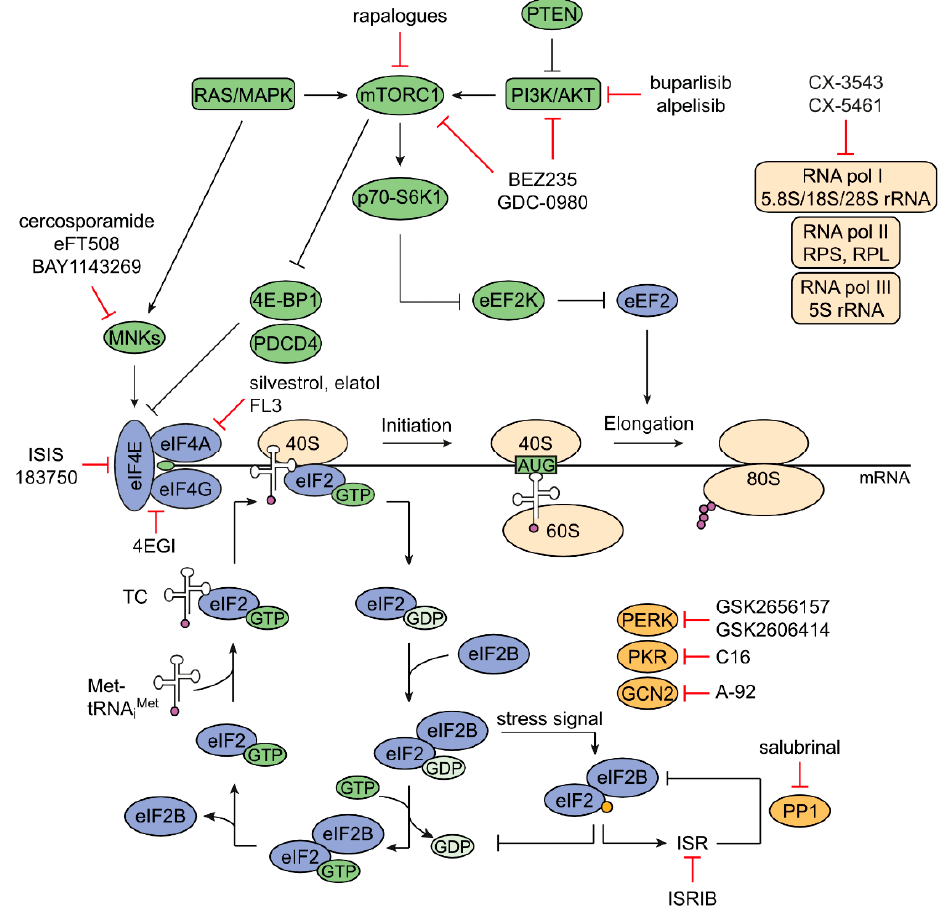
Figure 1. Schematic overview of regulation of mRNA translation and targeting possibilities in CRC. A large number of translation factors, signaling pathways, and ribosomal components are involved in the regulation of mRNA translation in general, and in particular in CRC. Di ff erent targeting strategies for interfering with deregulated protein synthesis have been developed as potential therapeutics, but clinical e ffi cacy has been limited so far. For simplicity, only translation factors and signaling proteins are shown, which are described as potential therapeutic targets in the text (discussed in detail in Section 4). Black lines with arrow: activating signal; black lines with T bar: inhibitory signal; red lines with T bar: inhibition by small molecules or other substances; violet dots: amino acids generating a polypeptide chain, yellow dot: phosphorylation; green dot: 7-methylguanosine cap of mRNA; TC: ternary complex; ISR: integrated stress response; RNA pol I–III: RNA polymerase I–III.